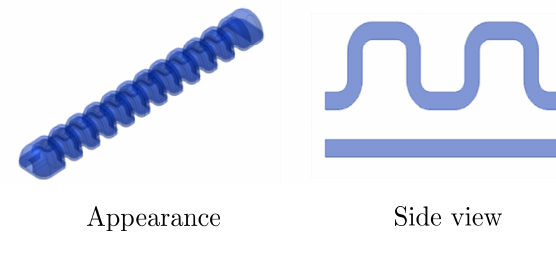
Figure 1. The overall appearance and a side view of the